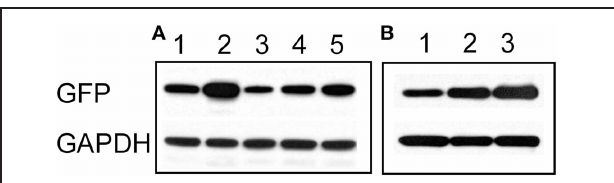
FIGURE 3 | (A) Increase in Cycs enhancer-driven GFP expression by bicuculline is suppressed by blocking neural activity. Lane 1, 48h untreated; lane 2, 48h bicuculline; lane 3, 48h TTX, lane 4, 48h bicuculline plus TTX; lane 5, 48h bicuculline plus APV (50 μ M) and CNQX (20 μ M). (B) Persistent effect of bicuculline on GFP expression. Lane 1, 8h bicuculline; lane 2, 48h bicuculline; lane 3, 8h bicuculline plus 40h after washout of bicuculline. Glyceraldehyde-3-phosphate dehydrogenase (GAPDH) was used as a loading control.